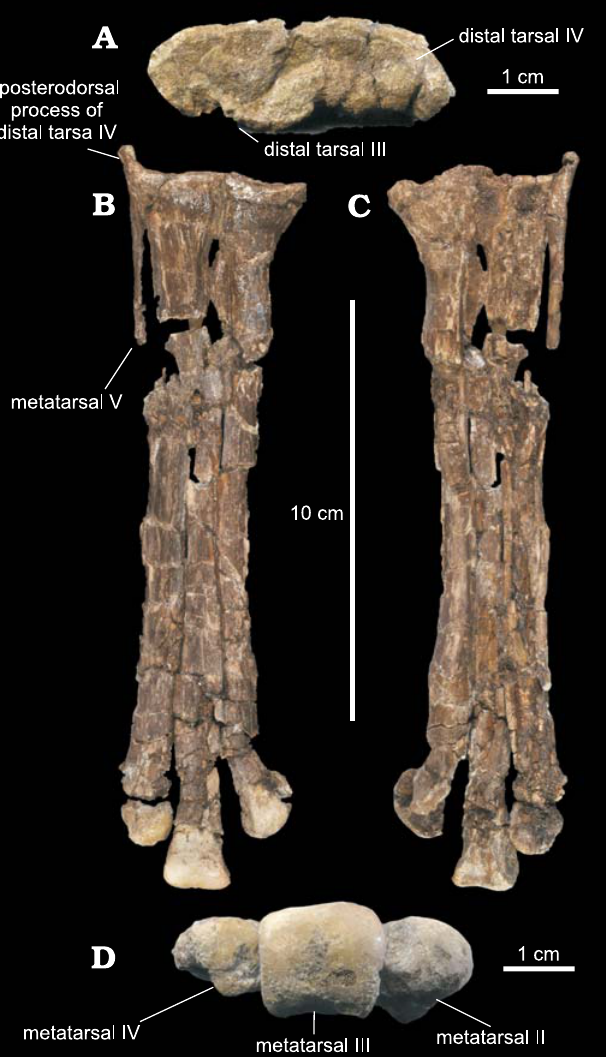
Fig. 5. Elmisaurine dinosaur Leptorhynchos elegans (Parks, 1933) (TMP 1982.016.0006) from the Upper Campanian Dinosaur Park Formation, Dinosaur Provincial Park, Alberta, Canada. Right tarsometatarsus in prox- imal ( A ), anterior ( B ), posterior ( C ), and distal ( D )